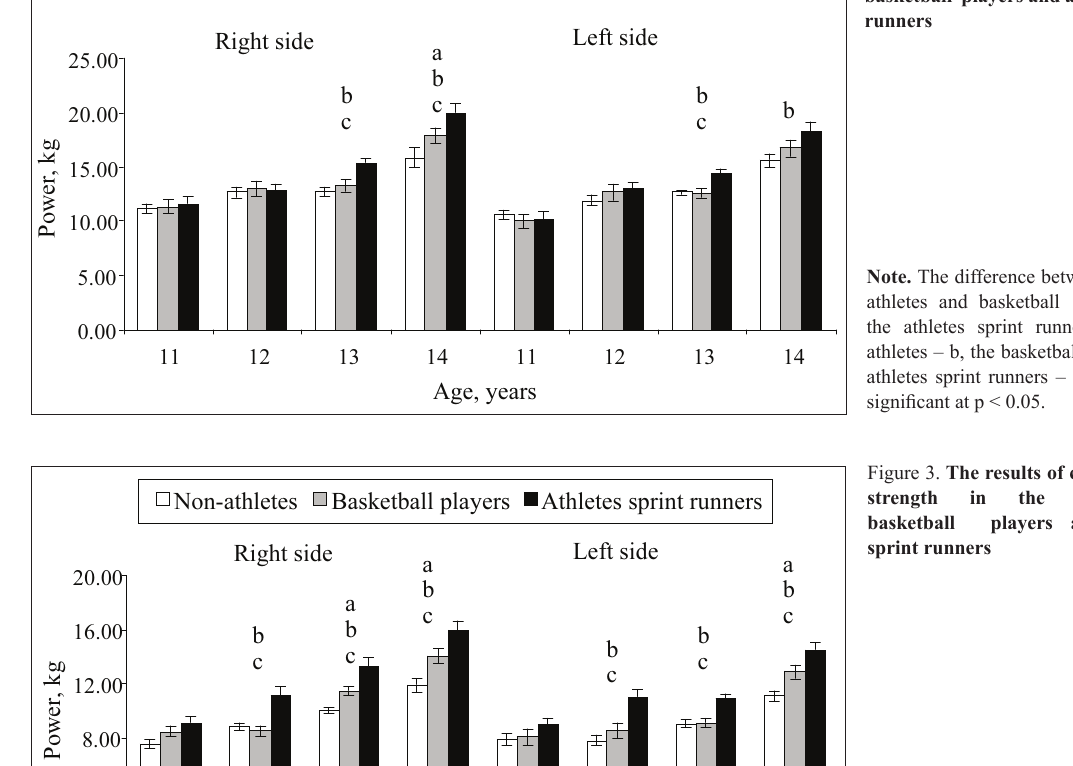
Note. The difference between: the non- athletes and basketball players – a, the athletes sprint runners and non- athletes – b, the basketball players and athletes sprint runners – c; statistically significant at p < 0.05.